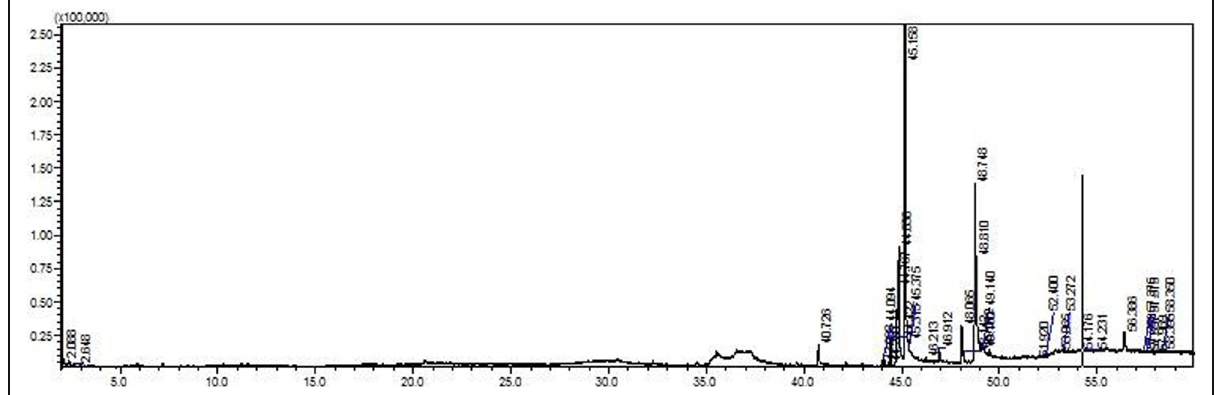
Fig. 2 GC-MS chromatogram of methanol extract of Pseudomonas